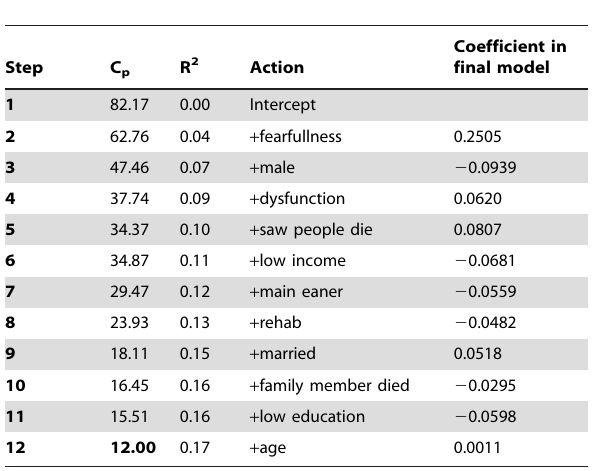
Table 4. Results from Least Angle Regression of